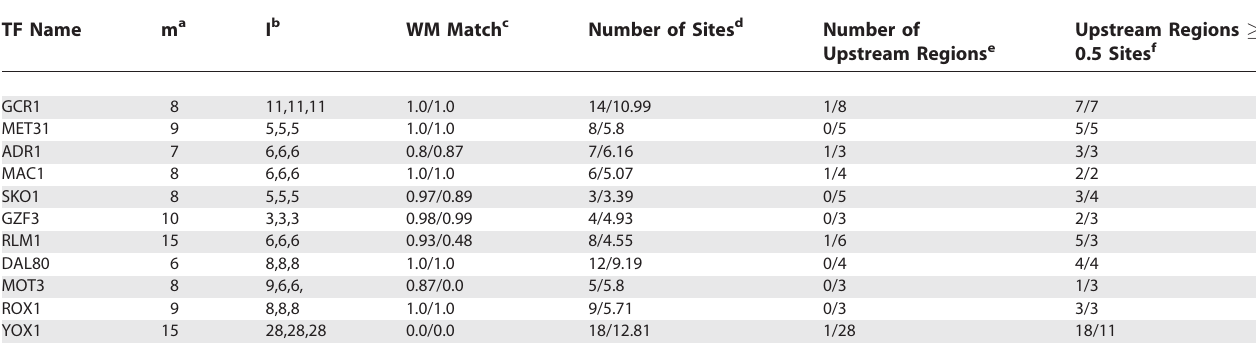
Table 3. Results of PhyloGibbs on Multiple Alignments of Upstream Regions Taken from the